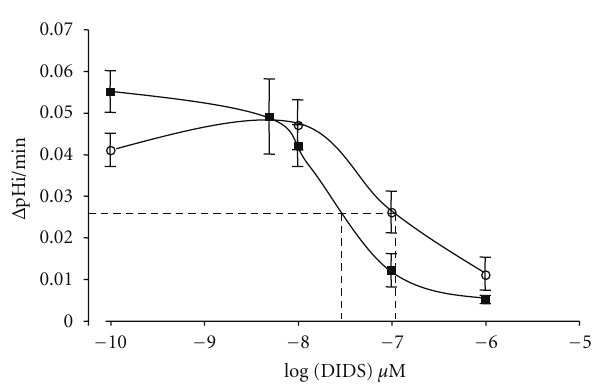
Figure 2: Dose response curves of Cl − /HCO 3 − exchange by DIDS. The capacity of oocytes expressing wt AE1 or R760Q mutant (10ng cRNA co-injected with 2.5ng GPA-cRNA in both cases) to alkalinize in CO 2 /HCO 3 − bu ff er without extracellular Cl − (gluconate medium) was assessed in presence of di ff erent DIDS concentrations. The initial slope of alkalinization as a function of time was plotted against DIDS concentrations. The method used was described in a previous publication [25]. Data are means +/ − s.e.m. of 9 to 20 oocytes from di ff erent batches. Black symbols correspond to wt AE1 expressing oocytes, empty circles to R760Q mutant expressing